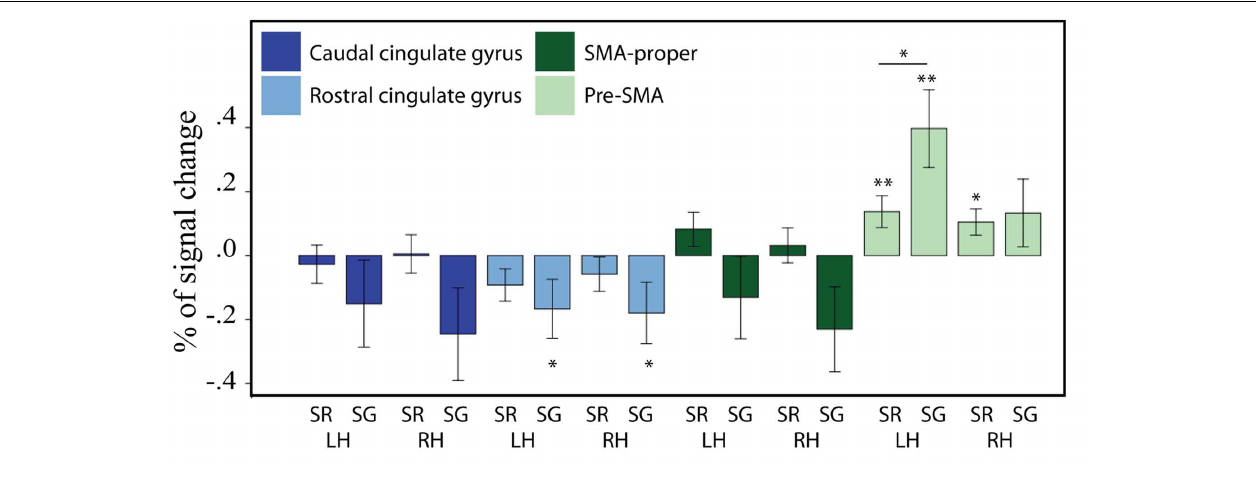
SMA-proper, and pre-SMA. Asterisks indicate significance level: double asterisk indicate that the statistics survive an FDR correction ( q = 0.05); single asterisk indicate uncorrected significance.The error bars represent the SE of the